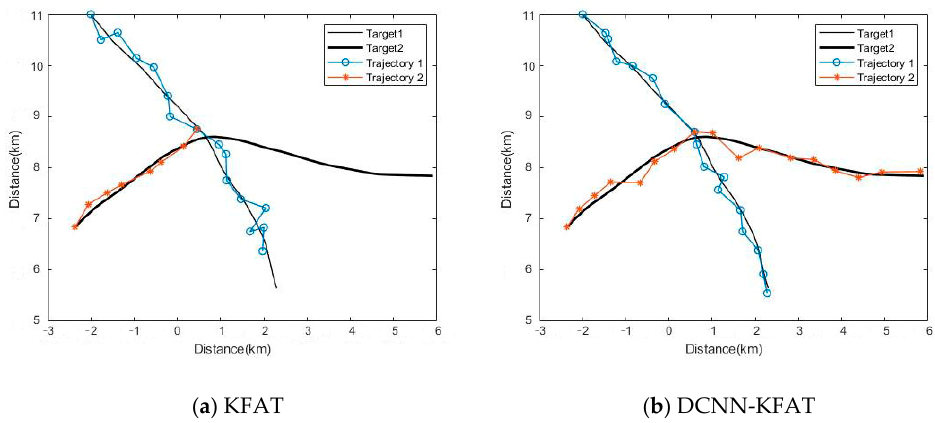
Figure 22. Results of processing the actual sea trial data using both methods. The KFAT method lost the orientation of one target.